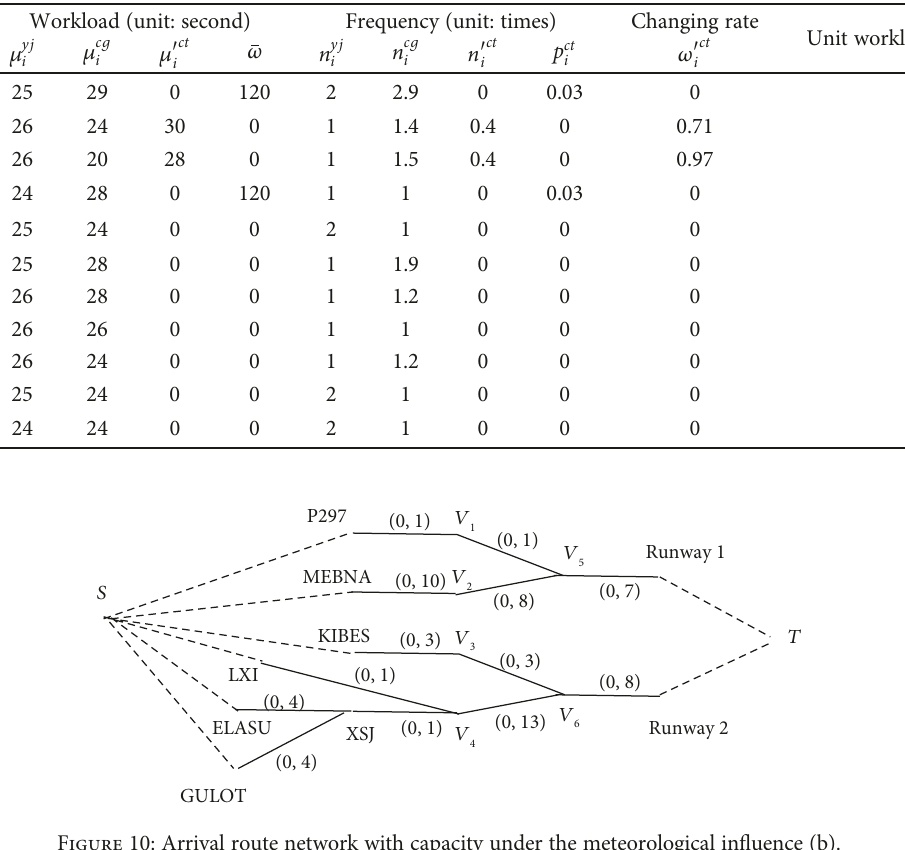
Table 8: Workload statistics of the sector 03.